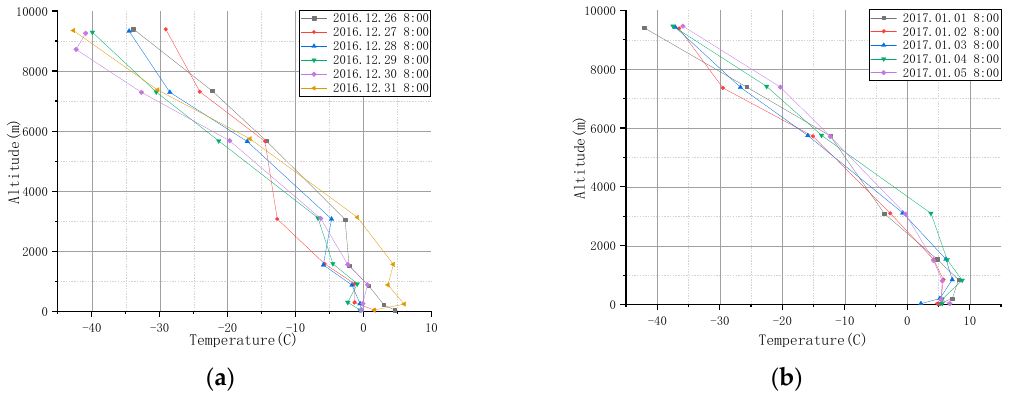
Figure 6. The vertical temperature profile: ( a ) December 26, 2016 to December 31, 2016; ( b ) January 1, 2017 to January 5, 2017.